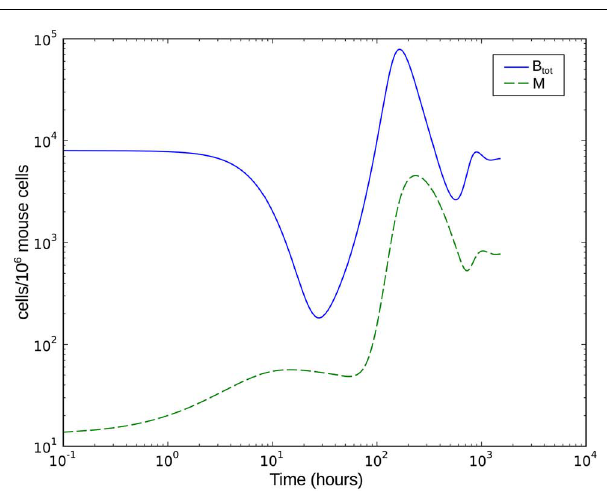
FIGURE 8 | Numerical simulation of the BB infection model with adaptation of the spirochaetes and humoral immune response. B tot is the total bacterial population size, M the number of phagocytic